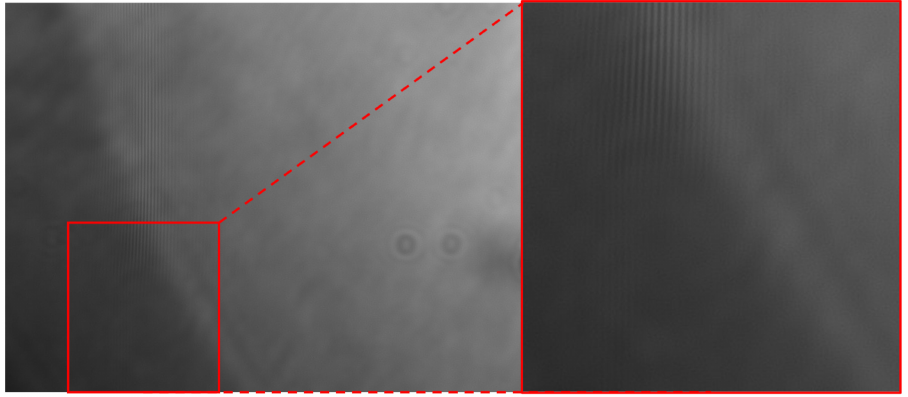
Figure 12. A typical incorrect